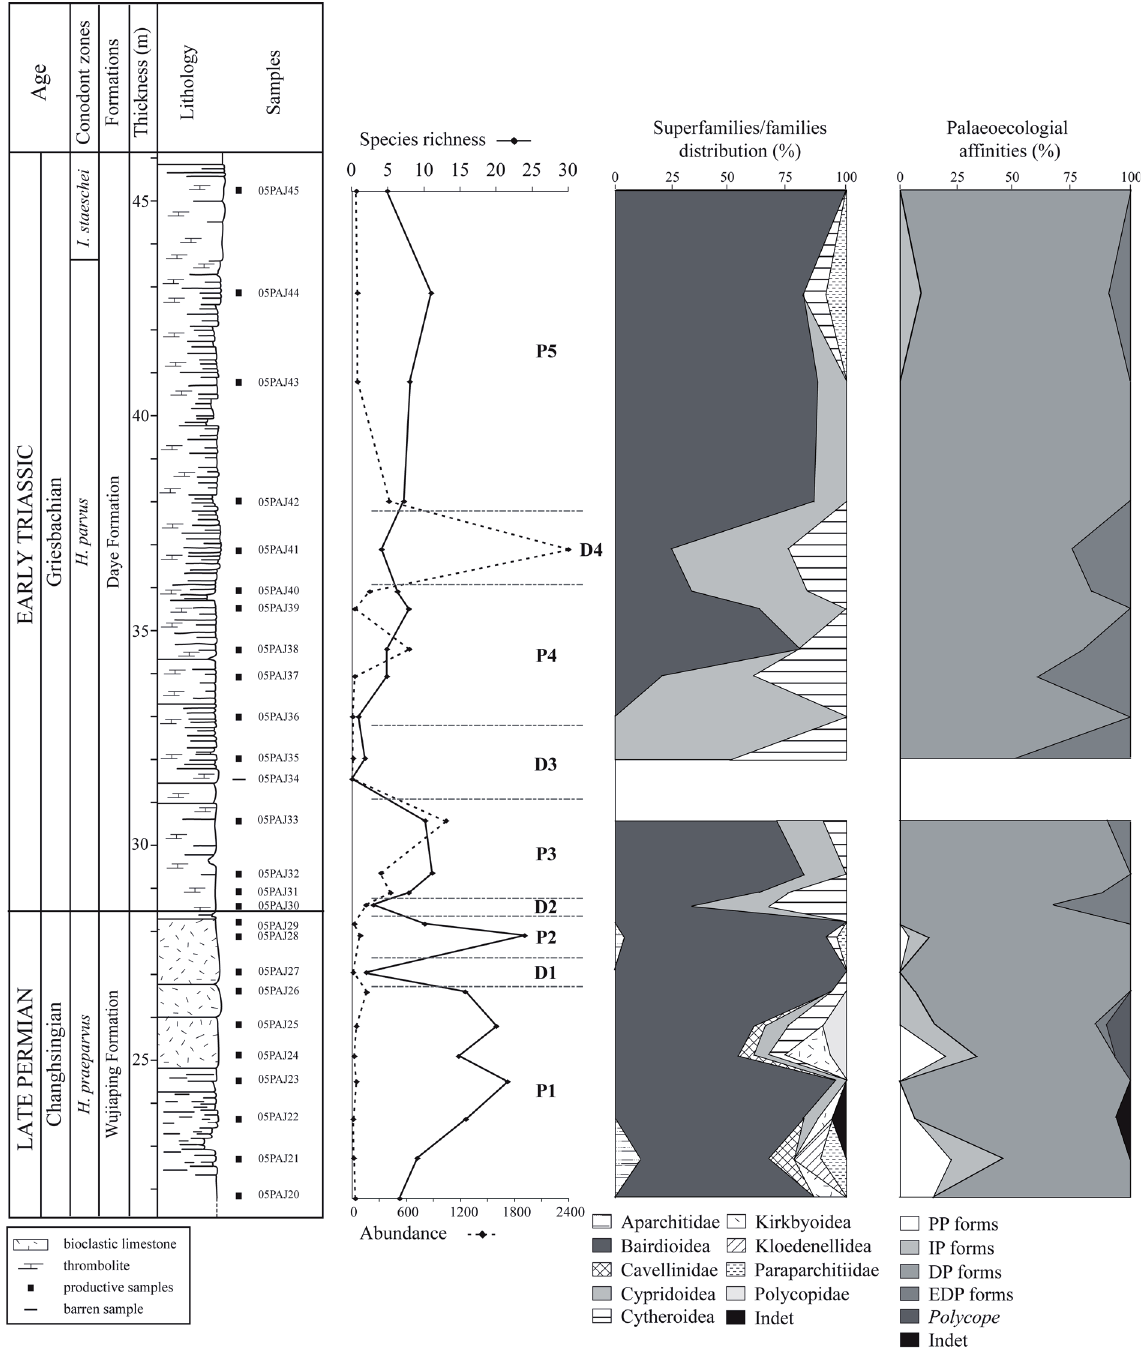
Fig. 16. Evolution of the ostracod faunas through the PTB in Dajiang. A . Evolution of the number of species (species richness) and number of specimens (abundance). B . Evolution of the relative proportions of each superfamily/family. C . Evolution of the relative proportions of each palaeoecological